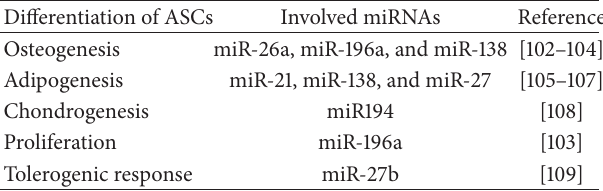
Table 4: miRNA expression of ASCs in culturing and differentia-